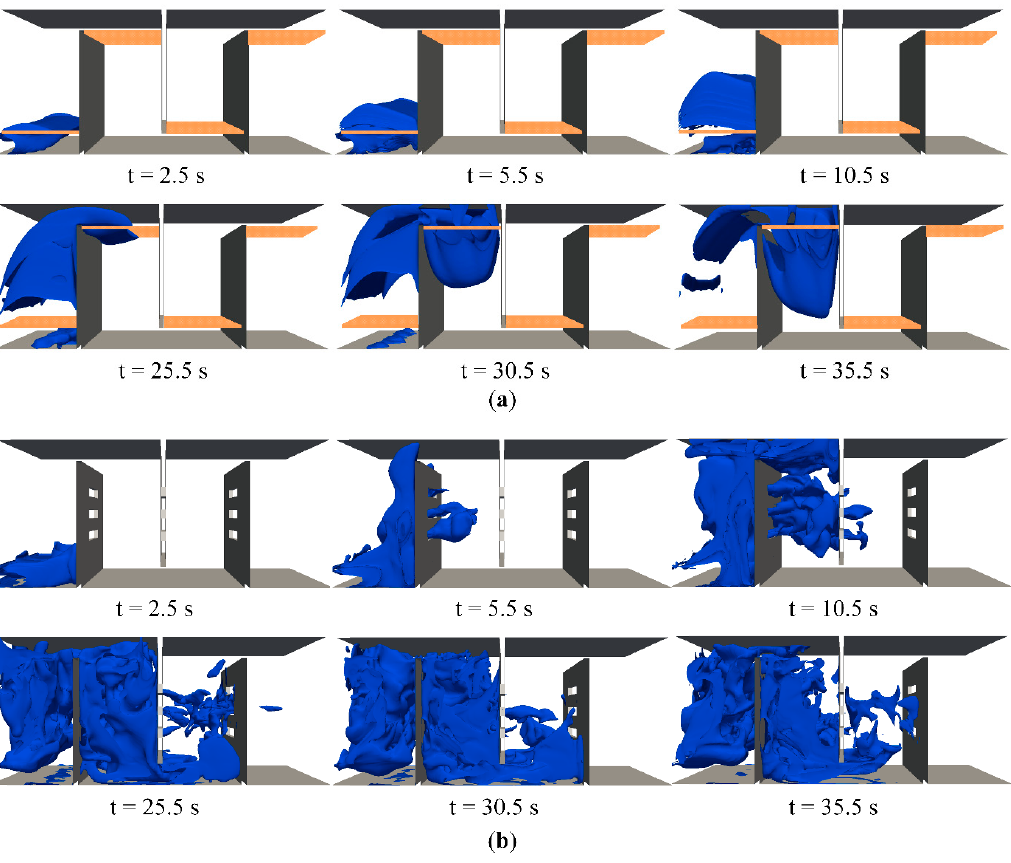
Figure 6. Transport of the tracer concentration at different time steps ( a ) Porous design 2 and ( b ) Slot-baffle design.